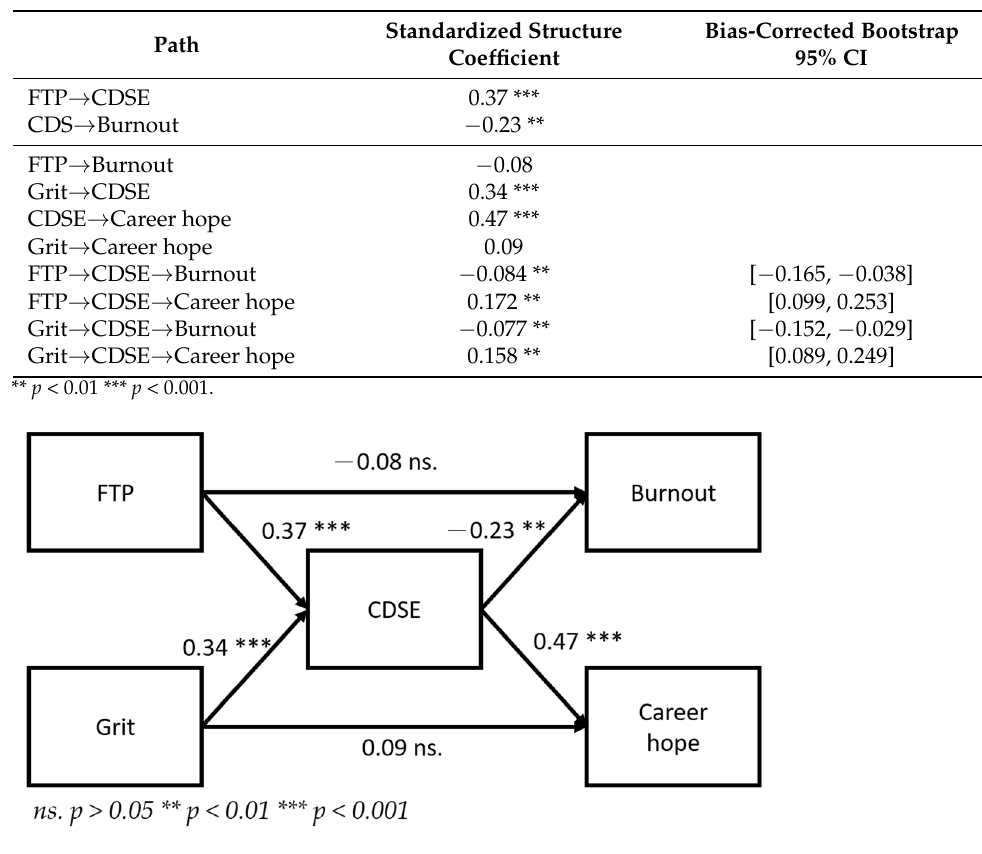
Figure 2. Path model with standardized